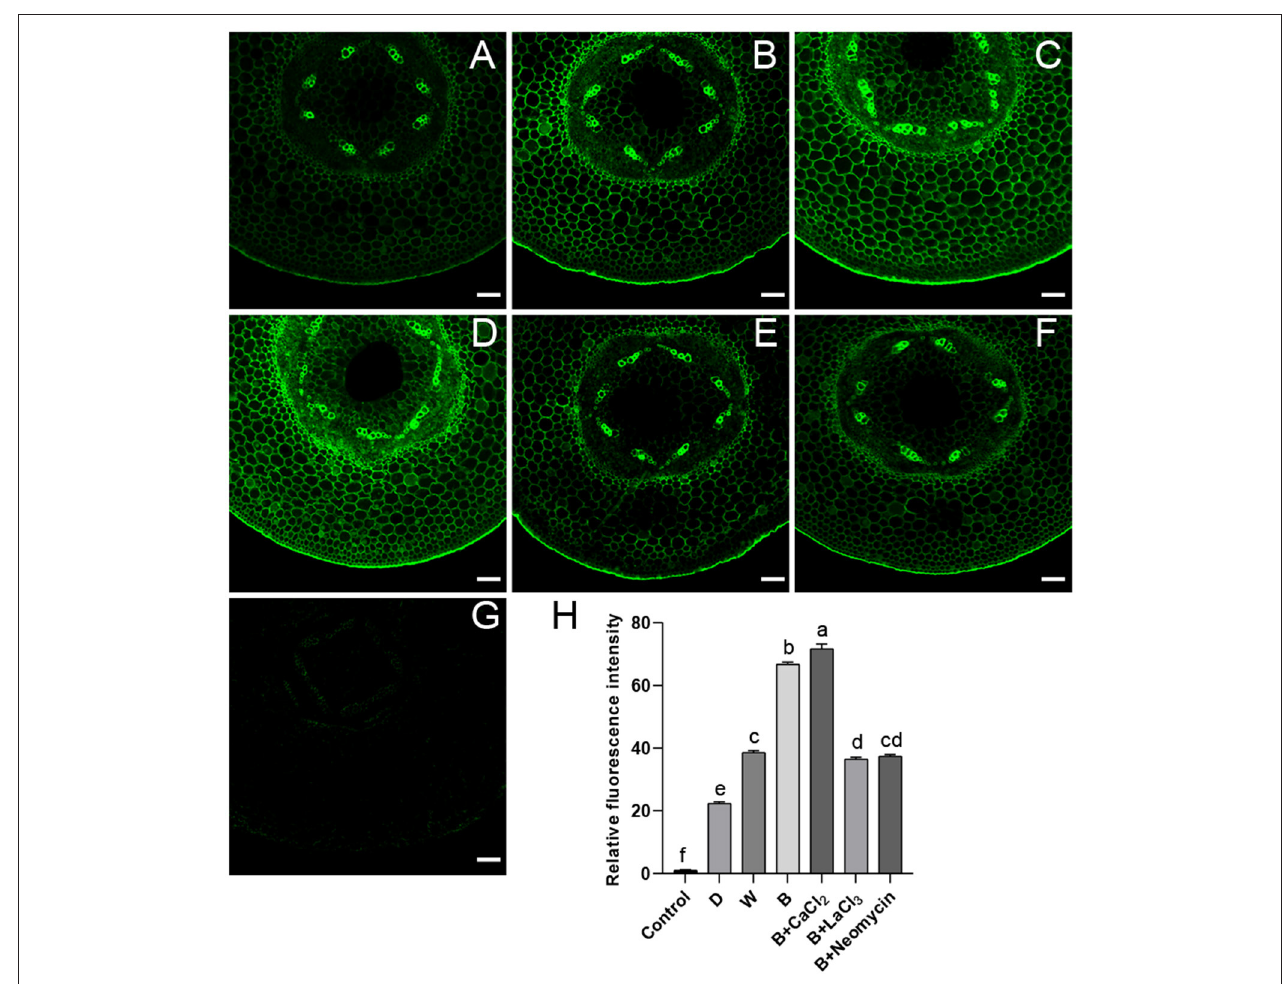
FIGURE 2 | Green fluorescent image of calcium in “Dongnong 690” hypocotyl cells at 24h under different conditions. (A–F) stand for treat with dark, white light, blue light, blue light + 3mM CaCl 2 , blue light + 1mM LaCl 3, and blue light + 1mM neomycin, respectively. (G) Hypocotyl was treated with distilled water without addition of probe. (H) Relative fluorescence intensity of calcium in different treatments. bar = 100 µ m. Values are the mean ± SE of triplicate ( n = 3). The different letters represent significant differences among various treatments ( p <